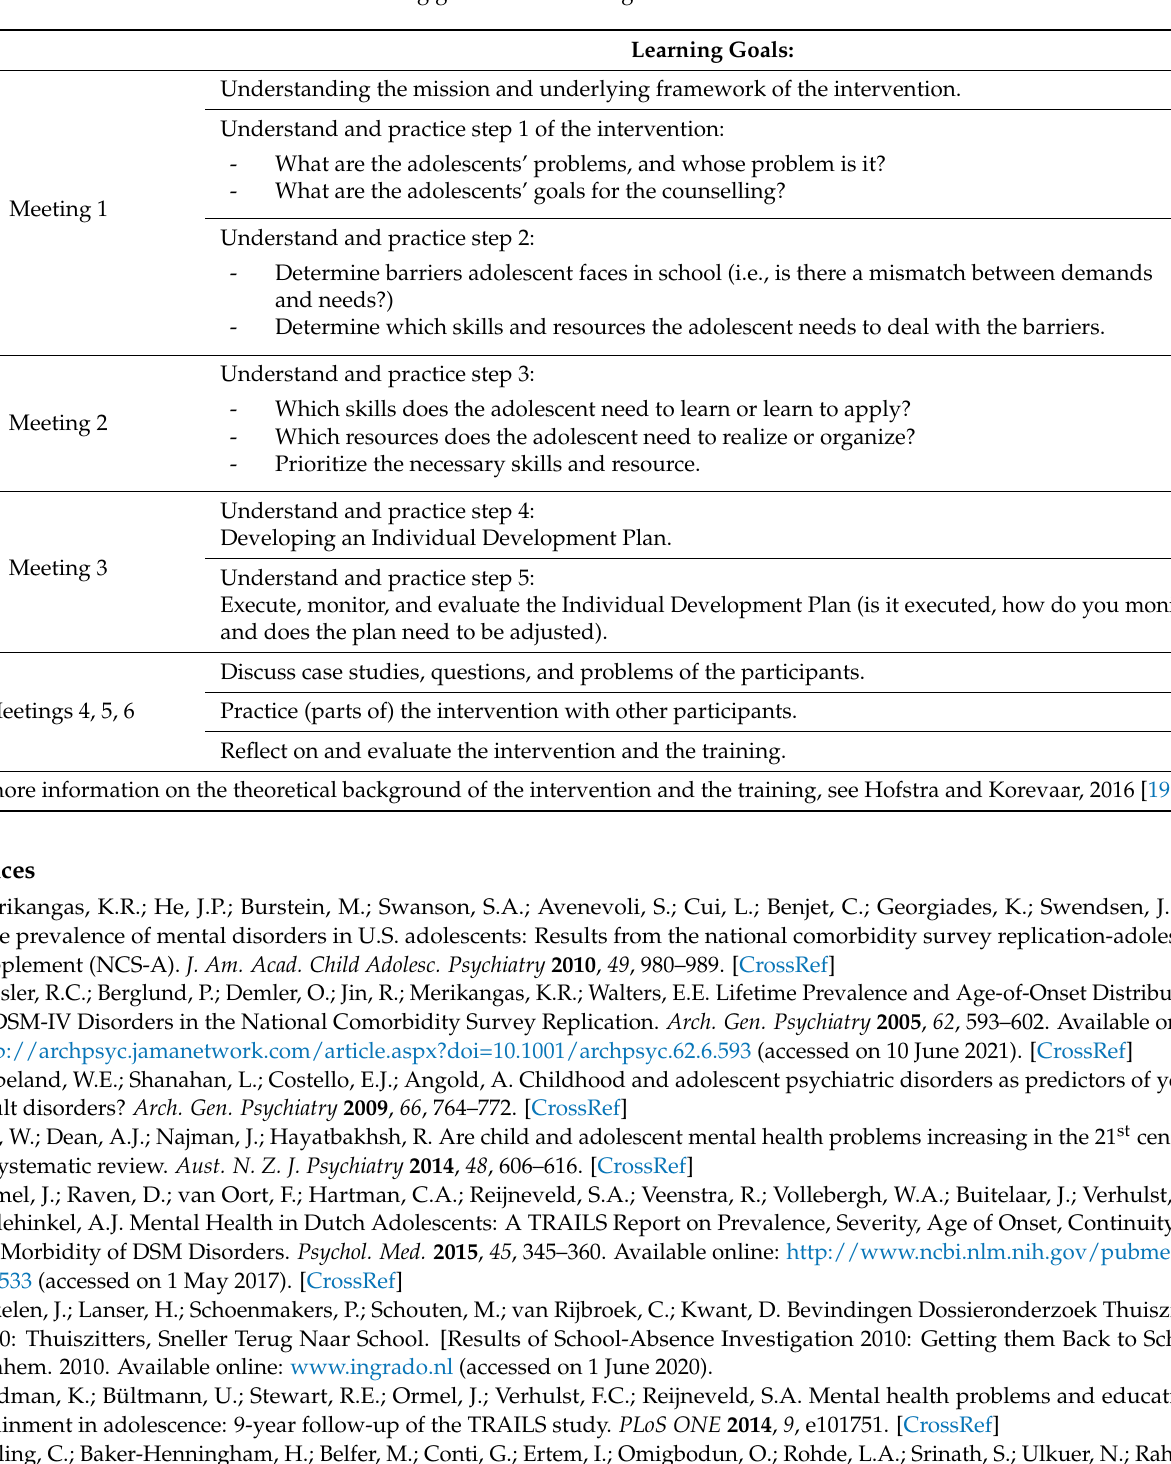
Table A1. Learning goals of the